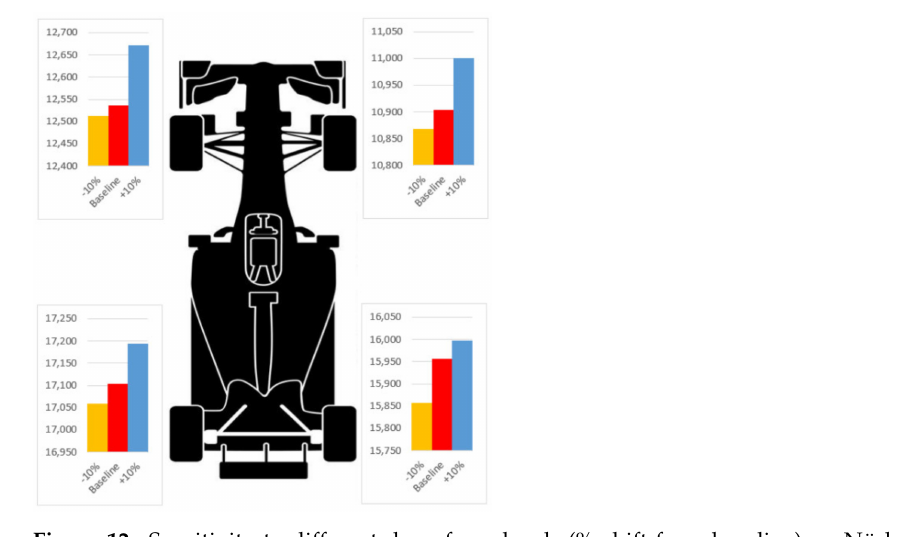
Figure 12. Sensitivity to different downforce levels (% shift from baseline) on Nürburgring GP. Energy is reported in